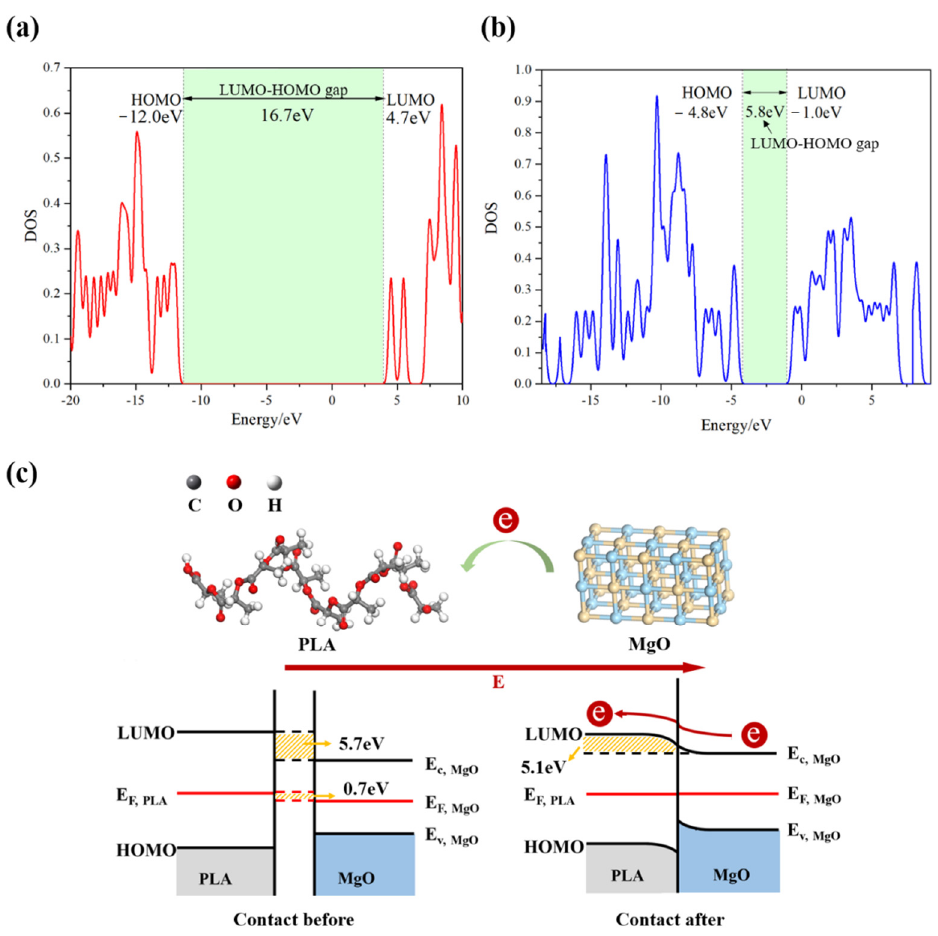
Figure 8. ( a ) DOS of PLA matrix; ( b ) DOS of MgO; ( c ) Band structures of PLA matrix and MgO before and after